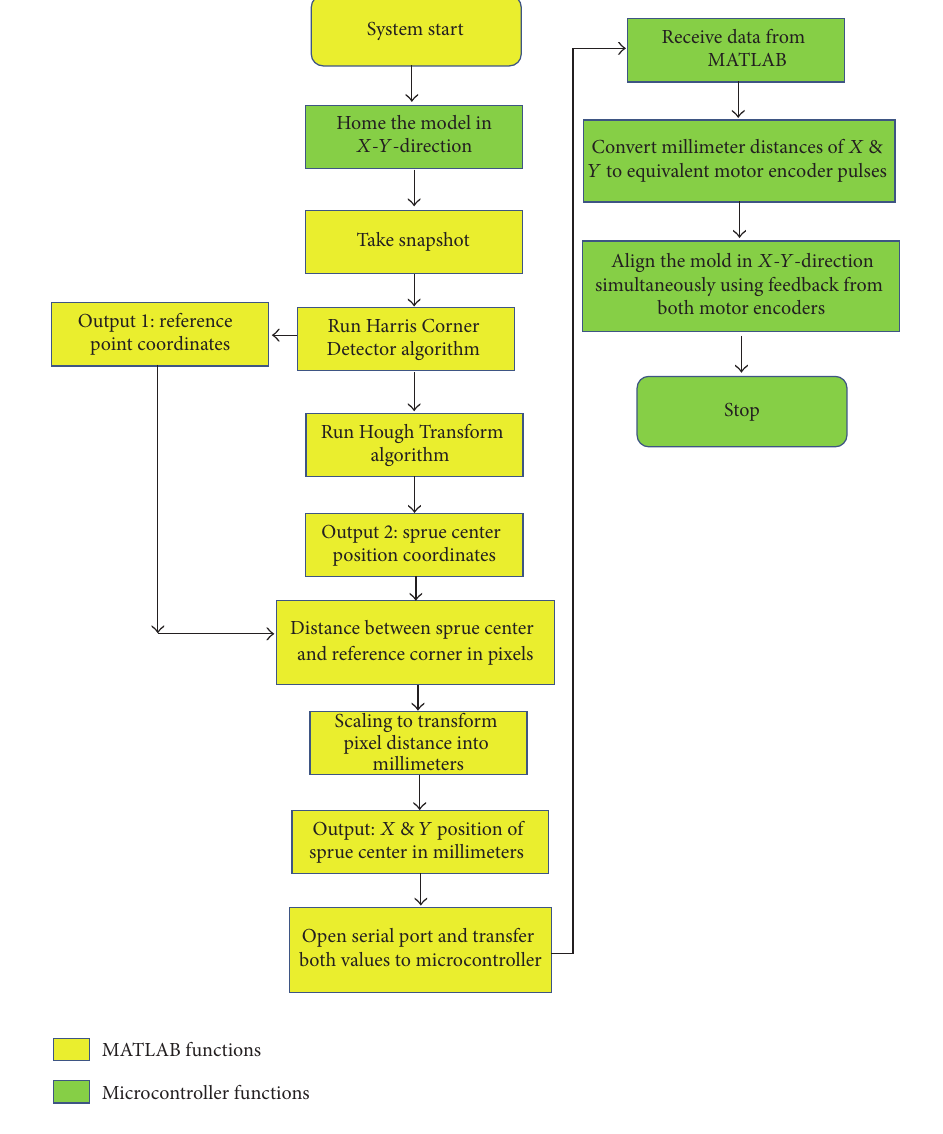
Figure 14: System flow of information.